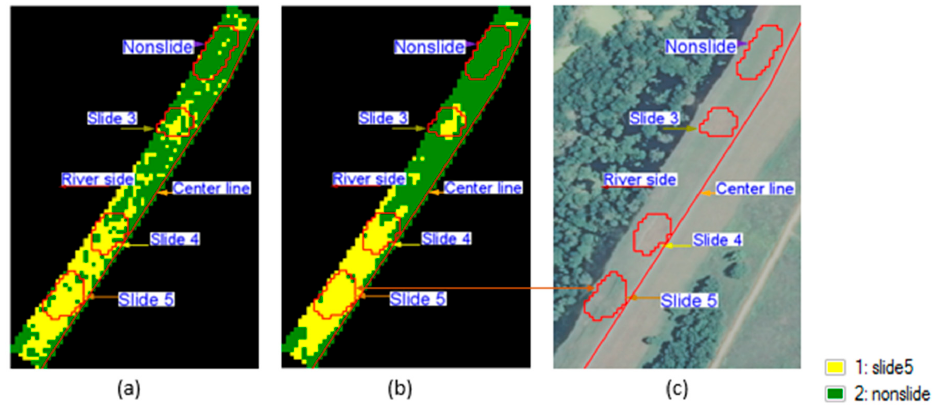
Figure 12. Magnitude data classification for the segment Sample 3: ( a ) without majority filter; ( b ) with majority filter; ( c ) optical image overlaid with slide and nonslide class shapes.